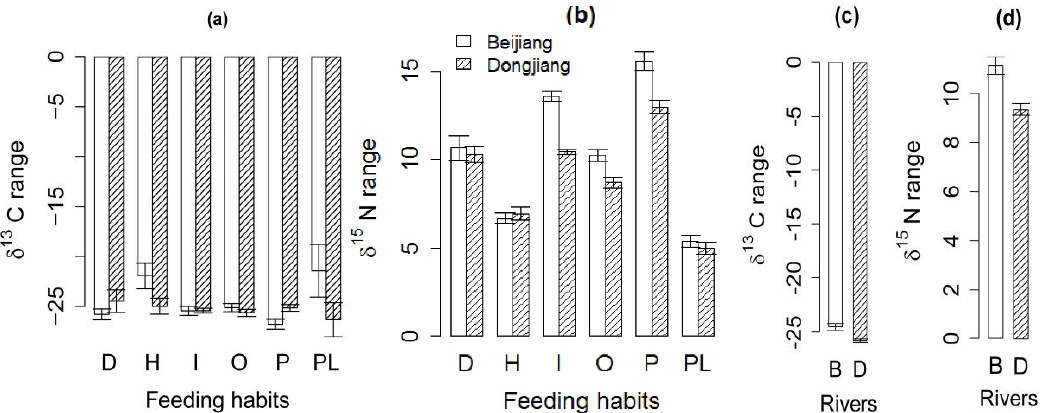
Figure 3. The difference in δ 13 C range and δ 15 N range between the invaded Dongjiang River and reference Beijiang River. B, Beijiang River; D, Dongjiang River. ( a ) Difference in δ 13 C range based on fish feeding habit. ( b ) Difference in δ 15 N range based on fish feeding habit. ( c ) Overall difference in δ 13 C range. ( d ) Overall difference in δ 15 N range. Further analysis revealed that invertivores ( t = −2.70, p = 0.04), omnivores ( t = −2.86, p = 0.032), piscivores ( t = − 1.87, p = 0.044), and planktivores ( t = − 2.69, p = 0.018) in the invaded Dongjiang River had a lower TA and a lower SEA than the reference Beijiang River, while the detritivores ( t = 1.59, p = 0.027) in the invaded Dongjiang River had a higher TA and a higher SEA than the reference Beijiang River (Figure 4a,b). In general, the invaded Dongjiang River had a smaller TA ( t = − 2.67, p = 0.011) and smaller SEA ( t = − 2.59, p = 0.015) than the reference Beijiang River (Figure 4c).